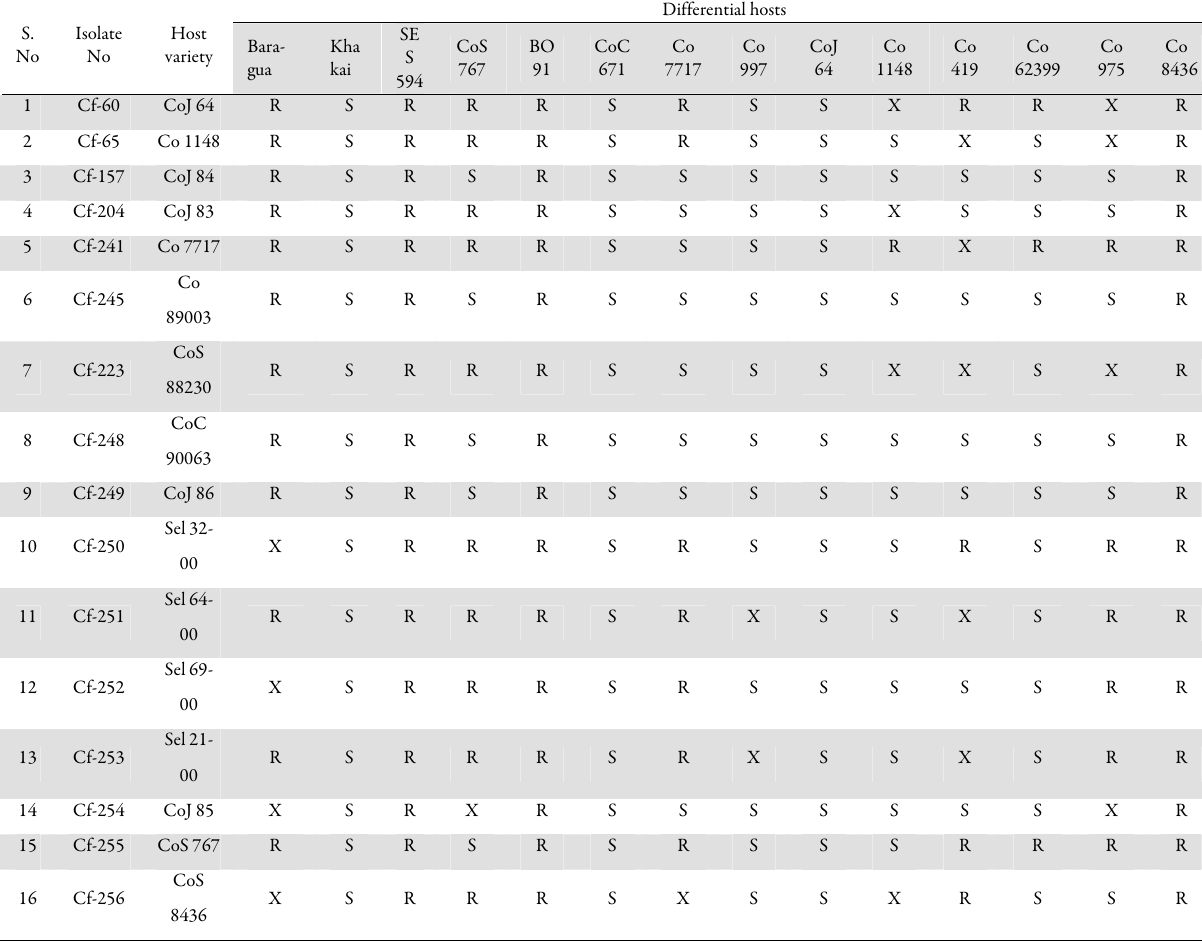
Tab. 4. Virulence frequency of isolates of Colletotrichum falcatum